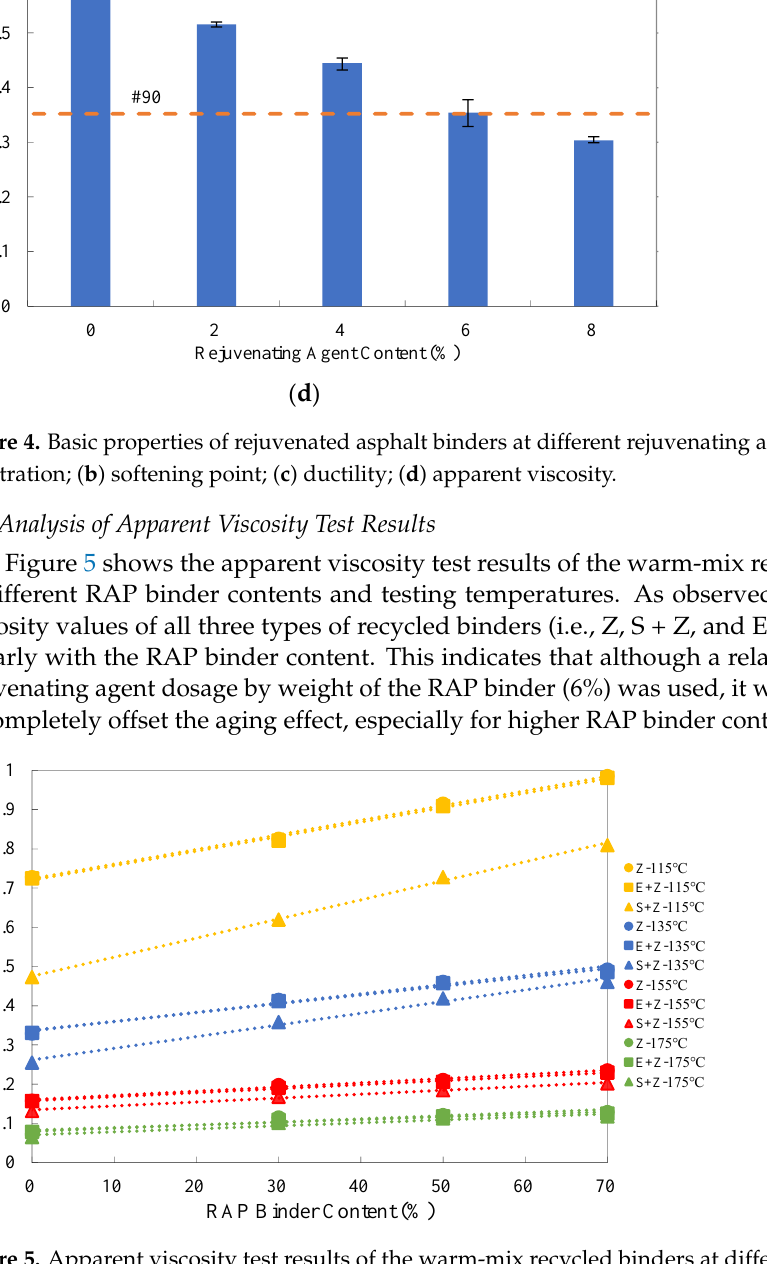
Figure 5. Apparent viscosity test results of the warm-mix recycled binders at different RAP binder contents and testing temperatures.